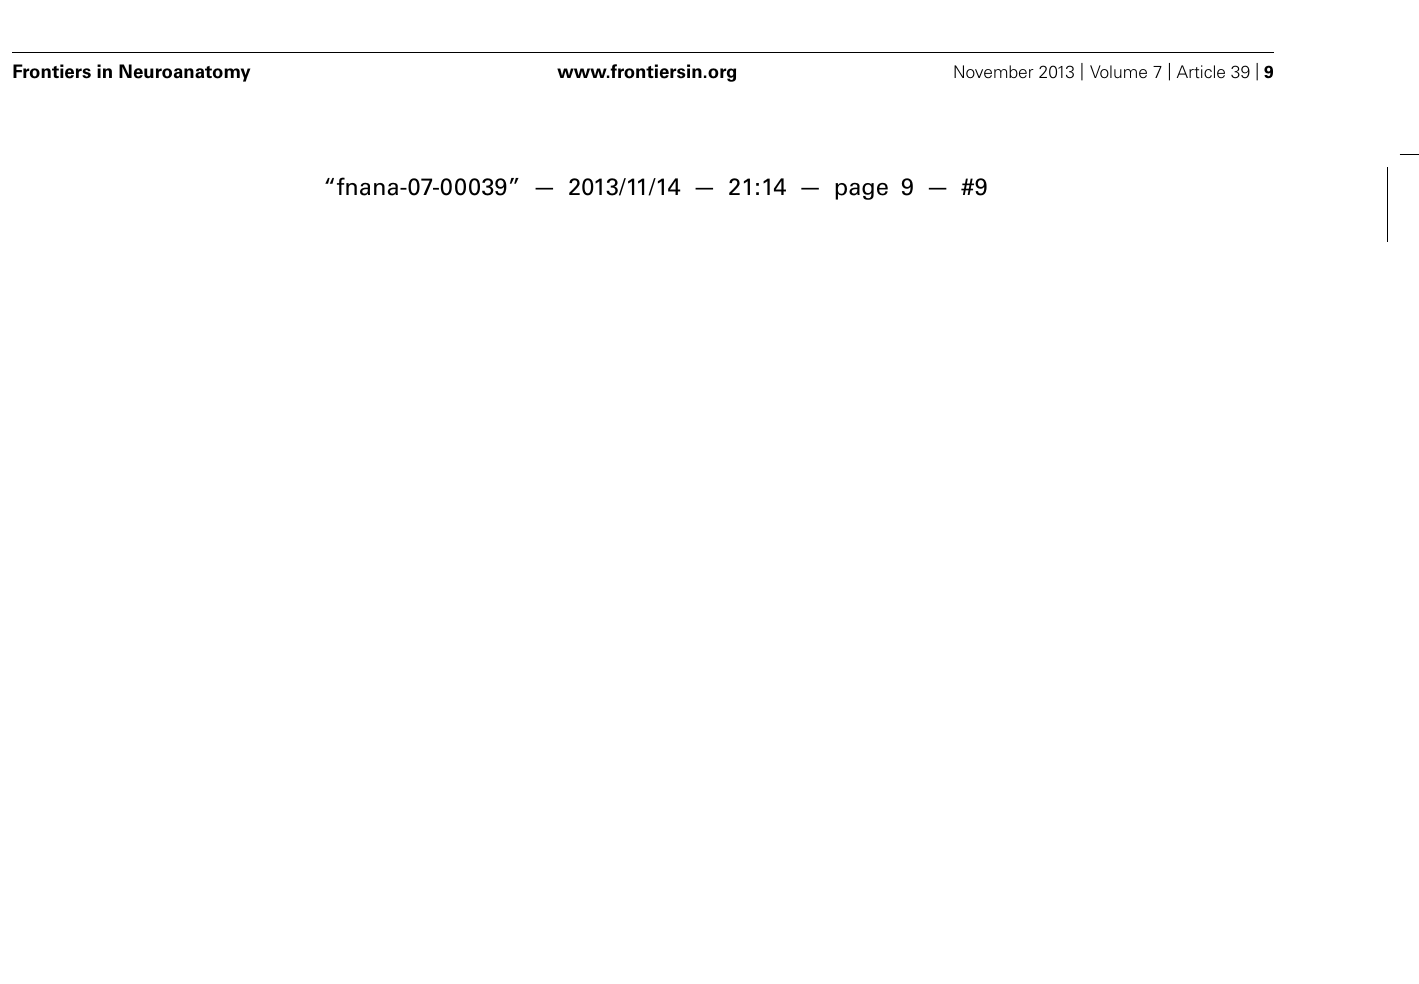
FIGURE 6 |Topography of the naked mole-rat cerebellum with electrophysiological mapping of cutaneous and periodontal responses from lobulus simplex A and B. (A) Illustration of the naked mole-rat cerebellum with a box delineating the area exposed by craniotomy. (B) Schematic of the microelectrode-derived map of